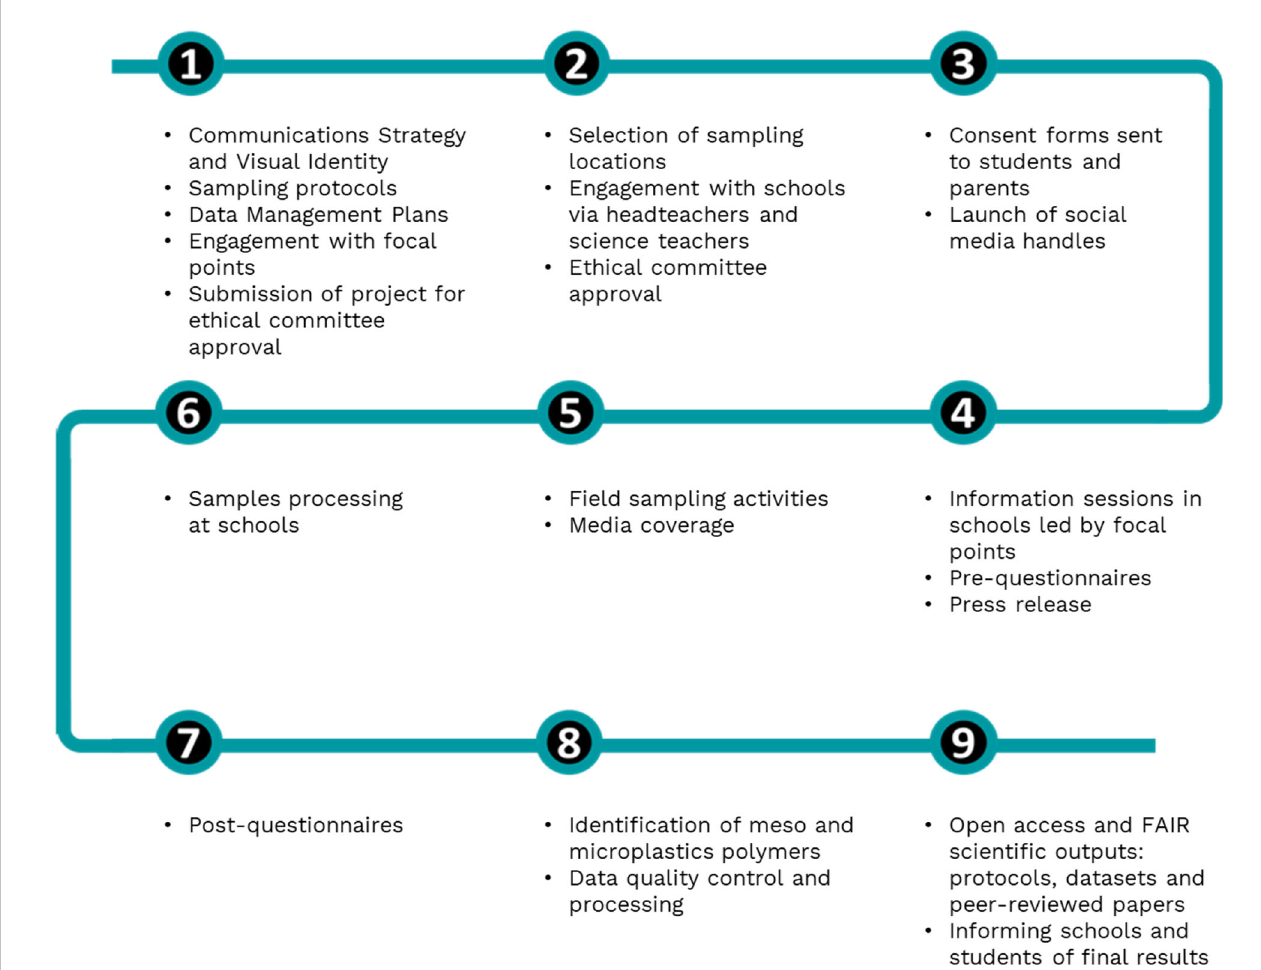
FIGURE 1 Work fl ow of COLLECT (Citizen Observation of Local Litter in coastal ECosysTems, 2021-2022), a citizen science project to acquire distribution and abundance data of coastal plastic litter in seven countries, in Africa (Benin, Cabo Verde, Co ̂ te d ’ Ivoire, Ghana, Morocco, Nigeria) and Asia (Malaysia), as well as to evaluate the educational, behavioral, and well-being impact of the citizen science intervention in the participating